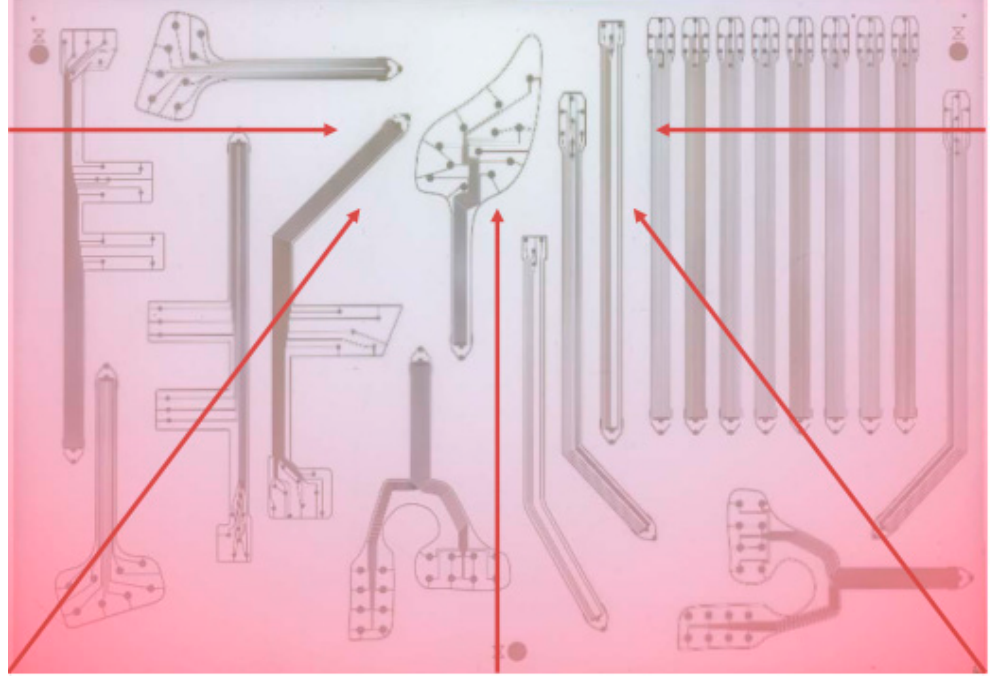
Figure 9. The heat map of the fabrication substrate (DIN A3) prone to shrinkage.